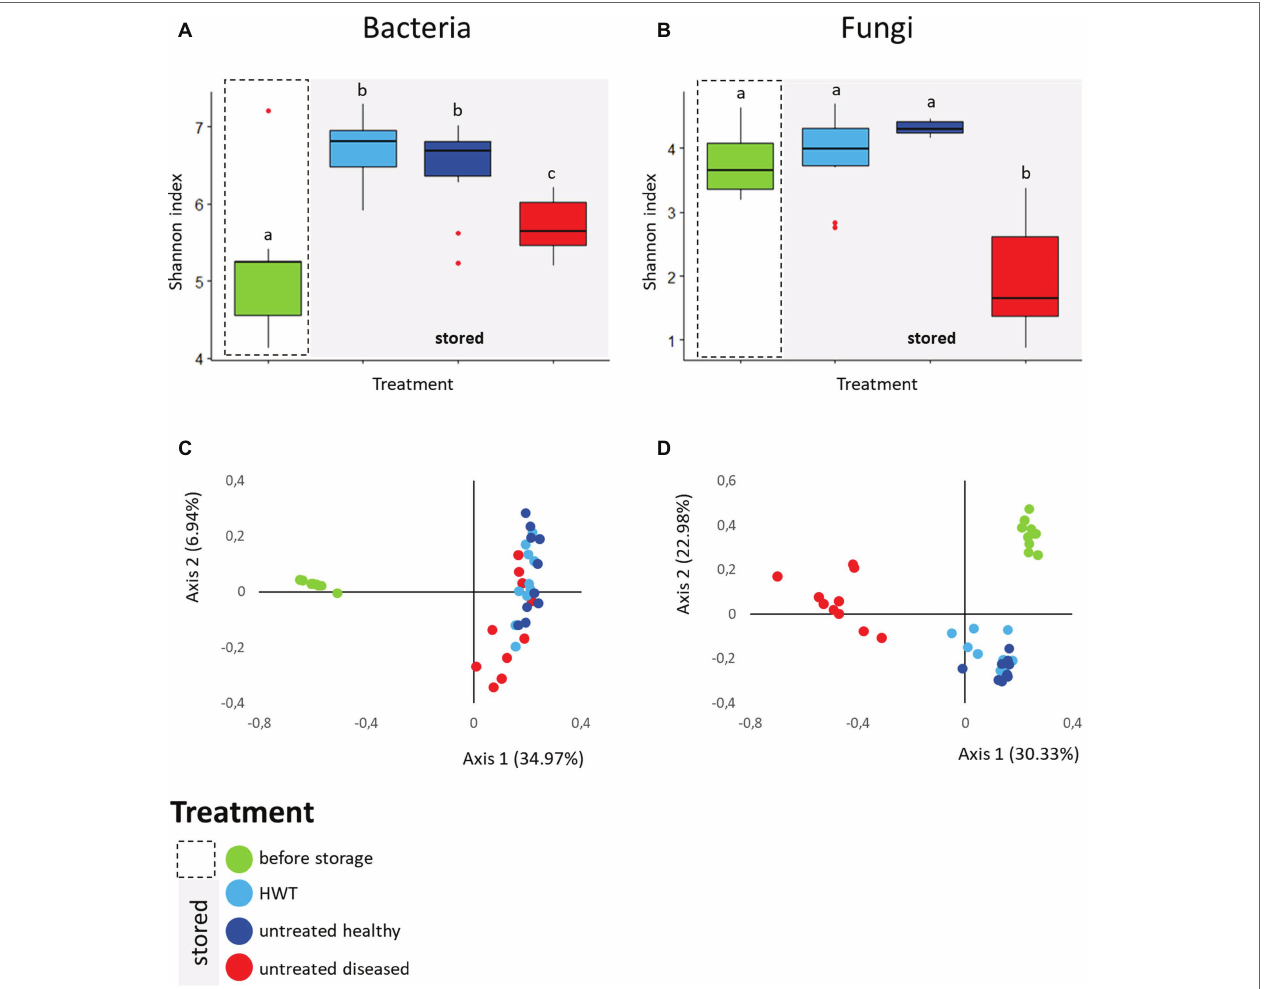
FIGURE 3 | Alpha- and Beta-diversity analyses on apple-associated bacterial and fungal structure. Box-and-Whiskers-plots visualize Shannon diversity index of the four different apple groups for bacteria (A) and fungi (B) . Significant differences ( p ≤ 0.05) were assessed by Kruskal Wallis test and are indicated by different lower case letters. Community clustering of bacterial (C) and fungal (D) composition of the samples is indicated by color-coded two dimensional Bray Curtis PCoA plots. Color code for the differentially treated apple samples is explained in the legend on the bottom left. Significant differences in bacterial and fungal composition was tested using ANOSIM pairwise test and can be looked up in Table 1